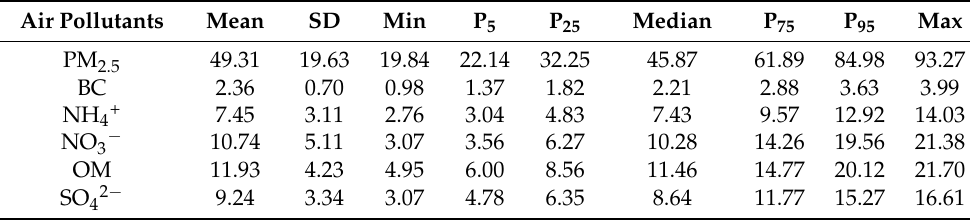
Table 2. The 1-year average concentration of the PM2.5 and its chemical constituent. Air Pollutants